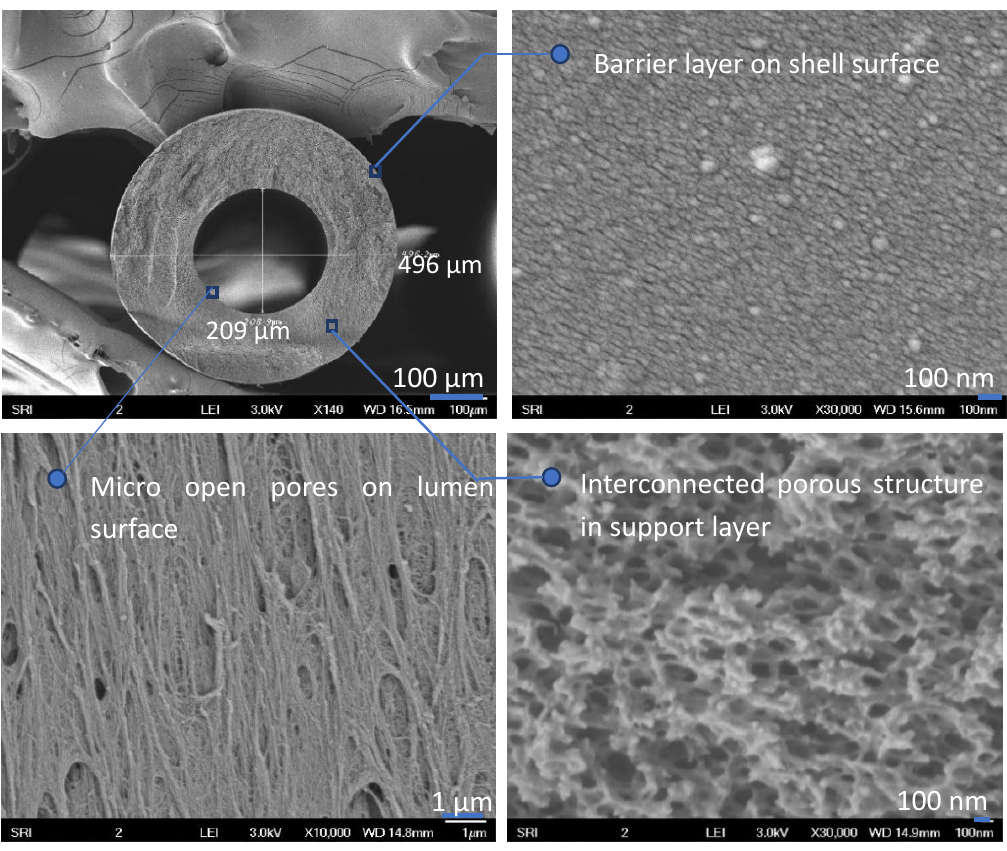
Figure 5 . Typical morphology of polybenzimidazole hollow-fiber (PBI HF) (air gap = 2.5”).